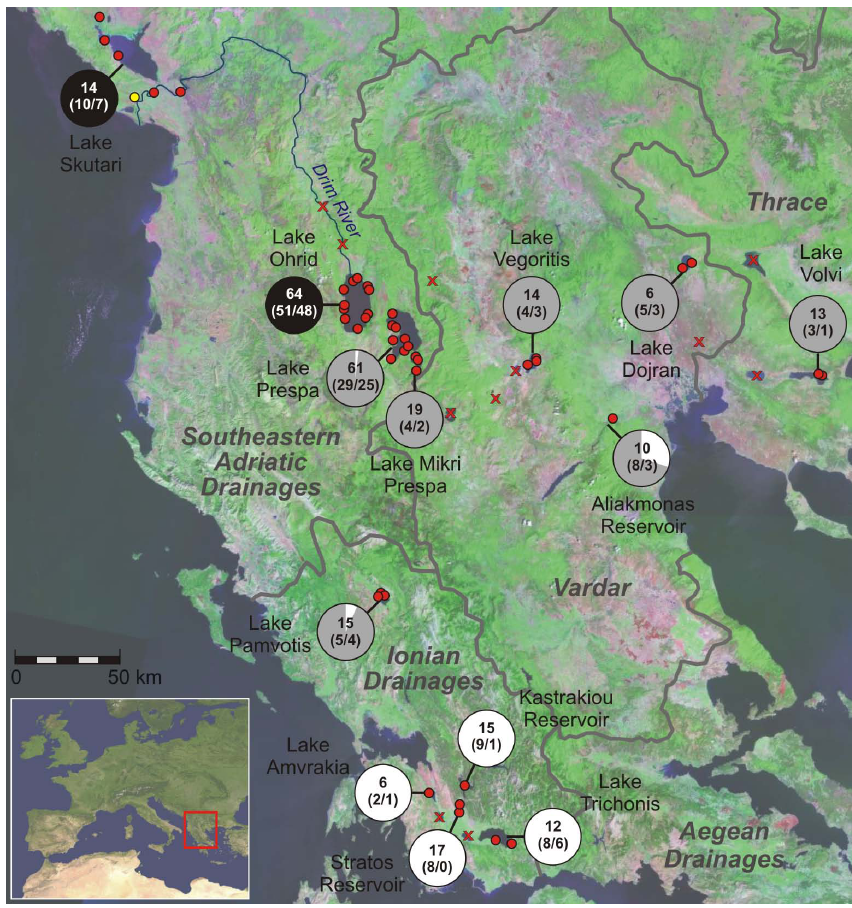
Fig. 1. Map of the southwestern Balkans showing the water bodies sampled for Dreissena spp. Records for native species are shown as red dots, for invasive species as yellow dot (for detailed locality information see Table 1). Negative records of Dreissena spp. are indicated by the x-symbol. Distribution of genetic groups of native species within the water bodies studied are indicated by coloured pie charts (black: “ D. stankovici ”, grey: D. presbensis , white: D. blanci ). Note that this assignment is a result of the present study. Numbers indicate total number of specimens studied from each water body (upper line) as well as the total number of haplotypes/private haplotypes found (lower line in parentheses). Major ecoregions are derived from Abell et al. (2008) and indicated by solid grey lines and italic names. Base map adapted from Mountain High Maps® , © 1993, Digital Wisdom® ,